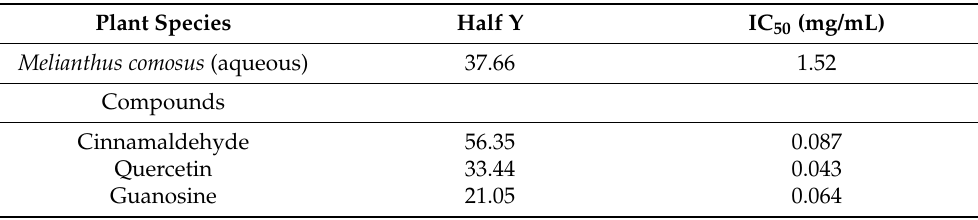
Table 3. Inhibitory (IC 50 ) values of the most active plant extract and compounds against C. violaceum .